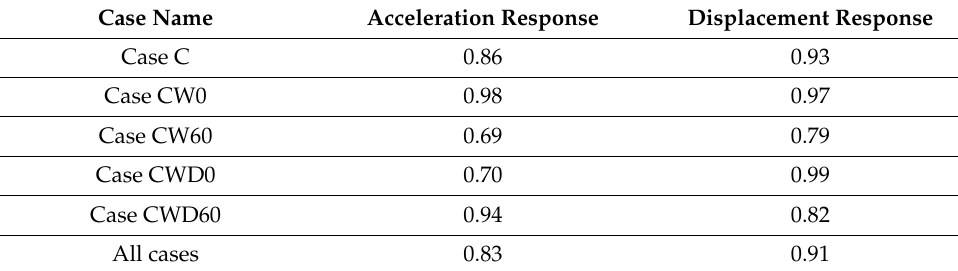
are 0.83 and 0.91, respectively. In particular, the minimum R 2 value was 0.69 in the Case